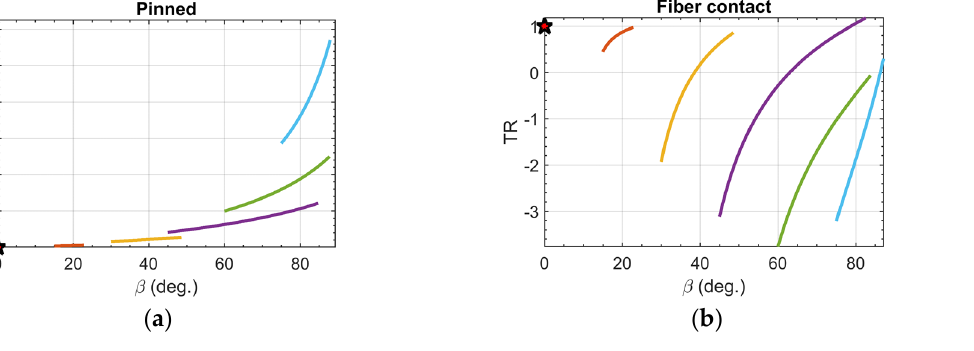
Figure 9. Variation in muscle transmission ratio of parallel ( β i = 0 ◦ ) and bipennate muscle bundles with pinned boundary condition ( a ) and fiber contact boundary condition ( b ). The legend shown on the far right indicates the fiber pennation angle of the muscle topology.